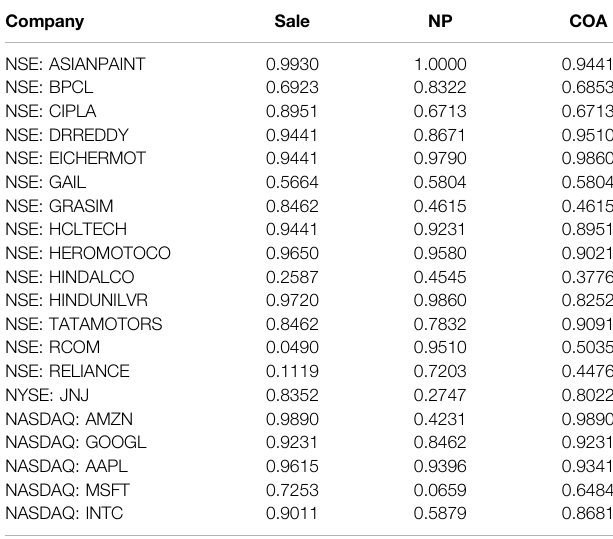
First column: Sale, second column: NP, and third column: